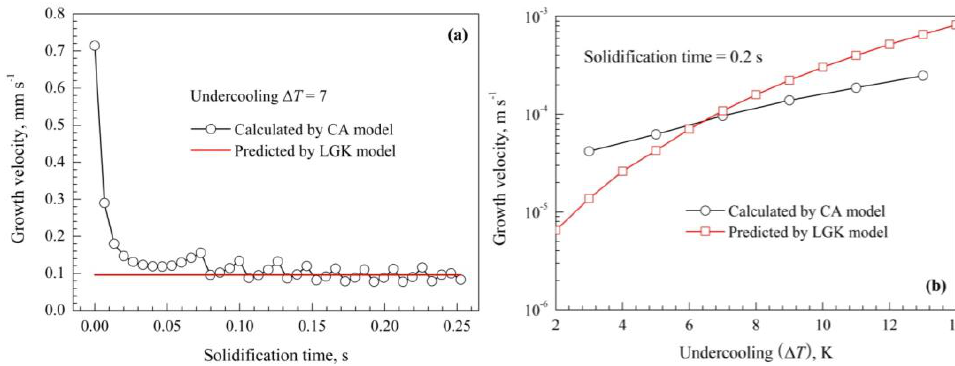
Figure 4. Comparison of growth velocity predicted by the CA and LGK (Lipton-Glicksman-Kurz) models with velocity units of ( a ) mm·s − 1 and ( b ) m·s − 1 .